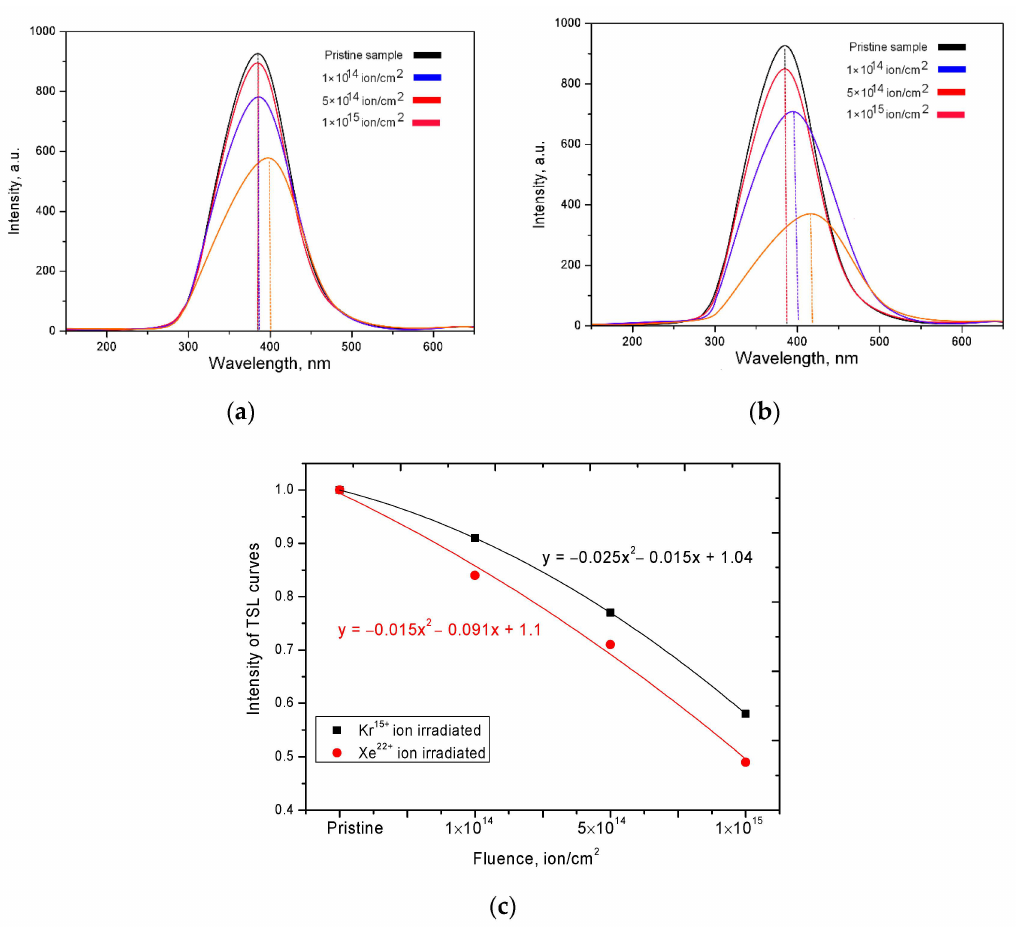
Figure 2. TSL curves versus wavelength: ( a ) Kr 15 + ion irradiated dose; ( b ) Xe 22 + ion irradiated dose; ( c ) Graph of the TSL curves’ intensity change depending on irradiation